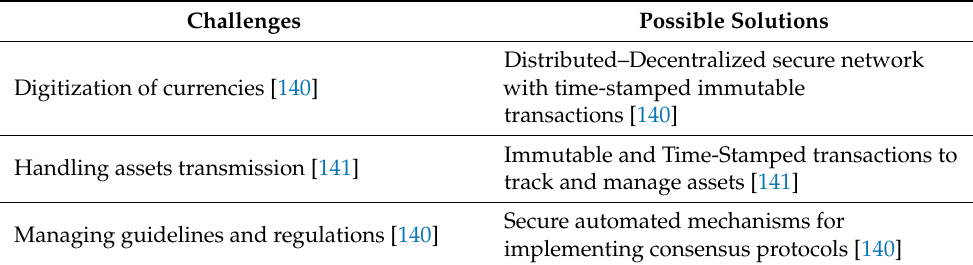
Table 5. Blockchain for